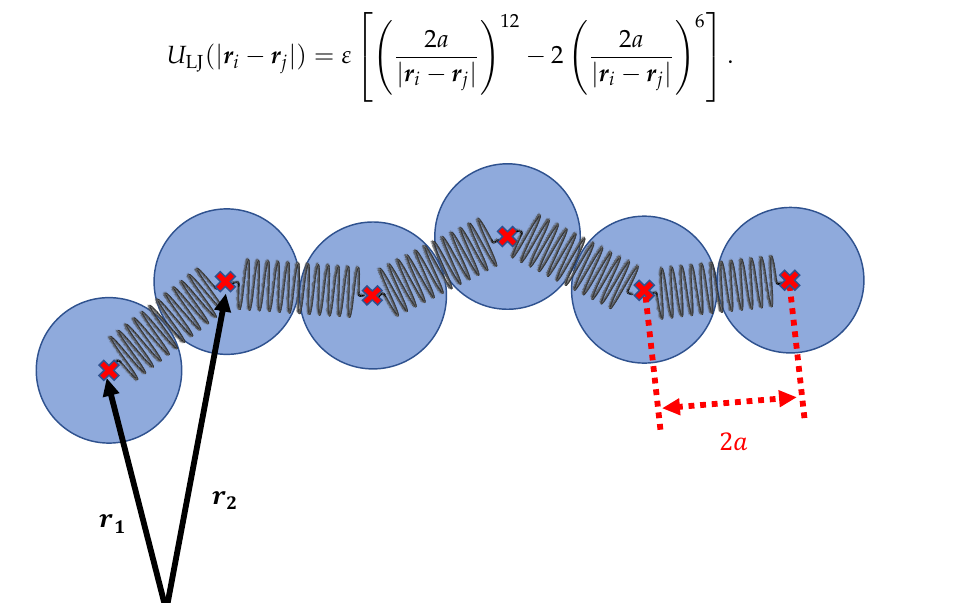
Figure 1. Schematic picture of the bead-spring model of the von Willebrand factor. The beads are numerated from 1 to N and their respective position vectors are denoted by r 1 , . . . , r N . The harmonic springs connecting consecutive beads have a stiffness of κ = 200k B Ta − 2